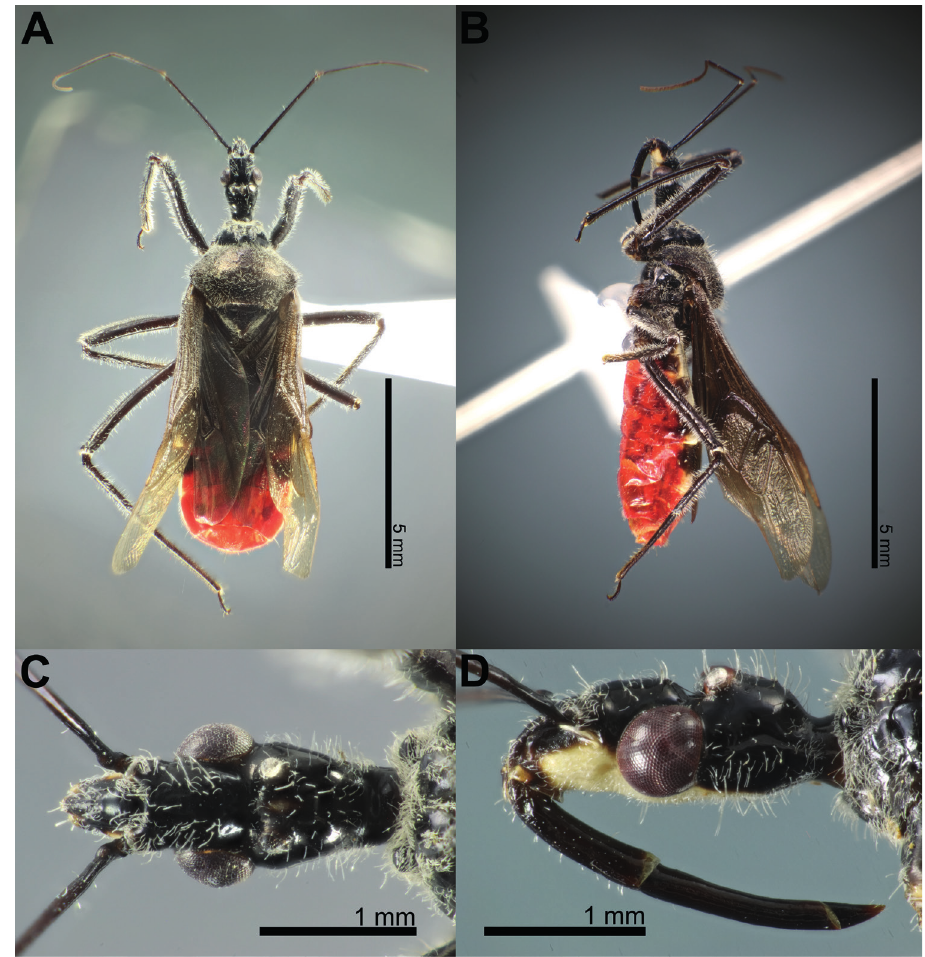
Figure 16. Biasticus griseocapillus Ha, Truong & Ishikawa, sp. nov., holotype, ♀ , HNL2018-038 A body in dorsal view B body in lateral view C head in dorsal view D head in lateral